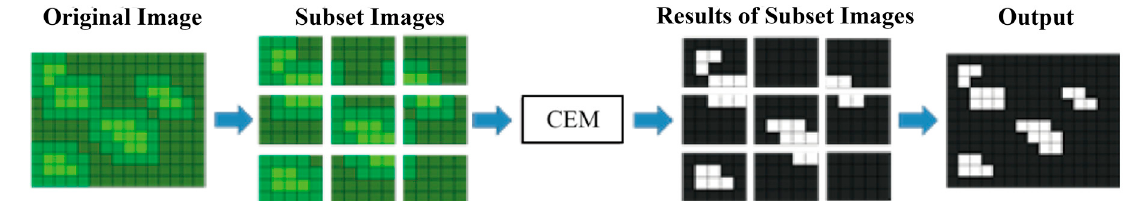
Figure 2. Schematic diagram of the division of subset images by Subset CEM.